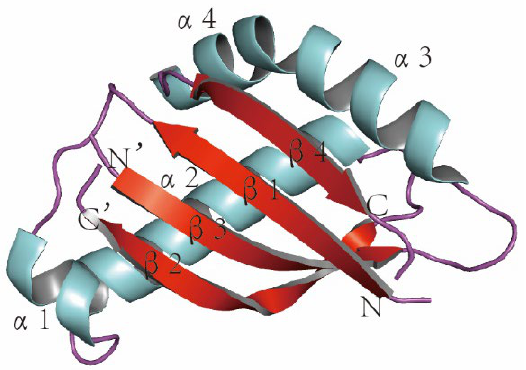
Figure 2. The 3D structure of MUC1 ( colored by secondary structure), α: alpha spiral, β: beta fold, N: NH 2 , and C: COOH. The 3D coordinate of the MUC1 structure (PDB ID: 2ACM) was retrieved from the Protein Data Bank (http:/www.rcsb.org/pdb/home.do) (accessed on 2 March 2022). The graphic was created by PyMOL (version 0.99; DeLano Scientific, San Carlos, CA, USA).